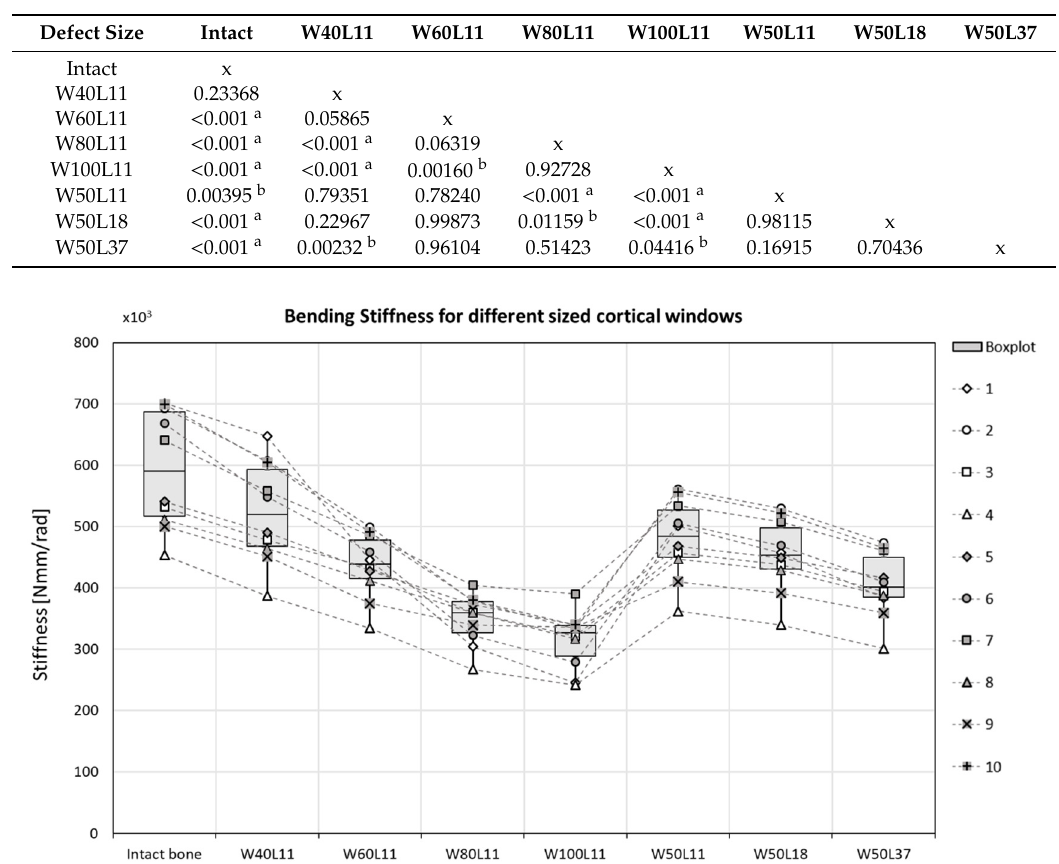
Figure 5. Varying the cortical window size does significantly change the maximum bending stiffness, before failure. The bending stiffness seems to be more affected by a change in width (defects 1–5) than by a change in height (defects 5–7). p -values are reported in Table 3. Table 3 Pairwise comparison (Welch’s test with Tukey correction) of the bending stiffness of bones with varying cortical defects leads to many statistical differences: a p -value < 0.001 and b p -value < 0.05.